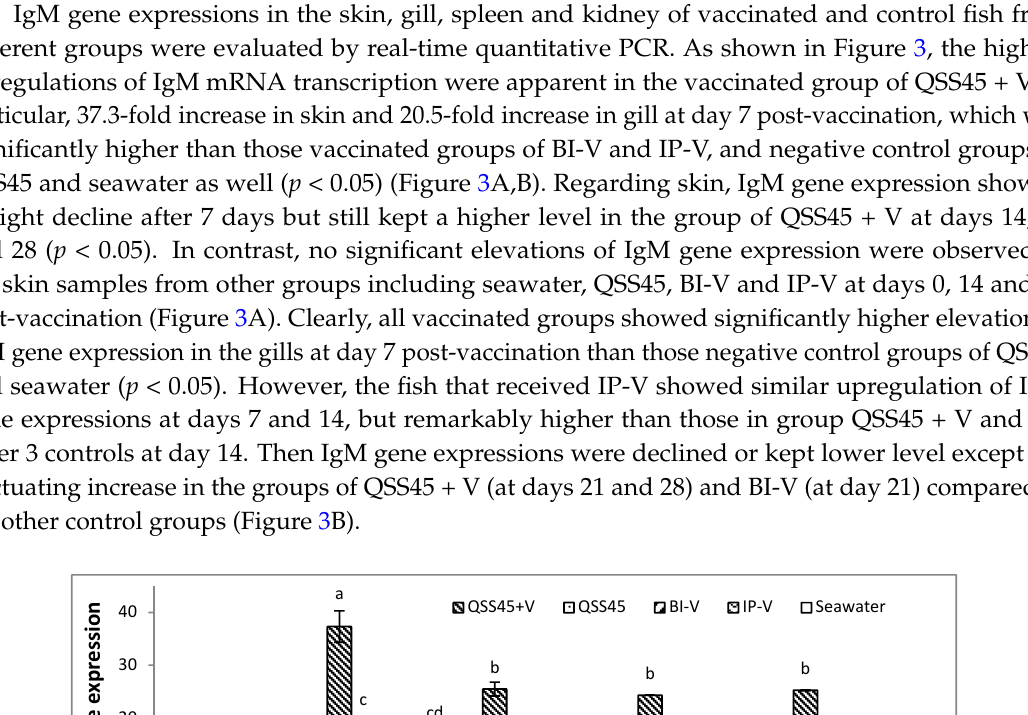
Figure 2. Specific antibody titers against V. anguillarum post-immunization in each group. Data represent as the mean value ± S.E. of three replicates. Significant differences ( p < 0.05) among groups were indicated by different letters.